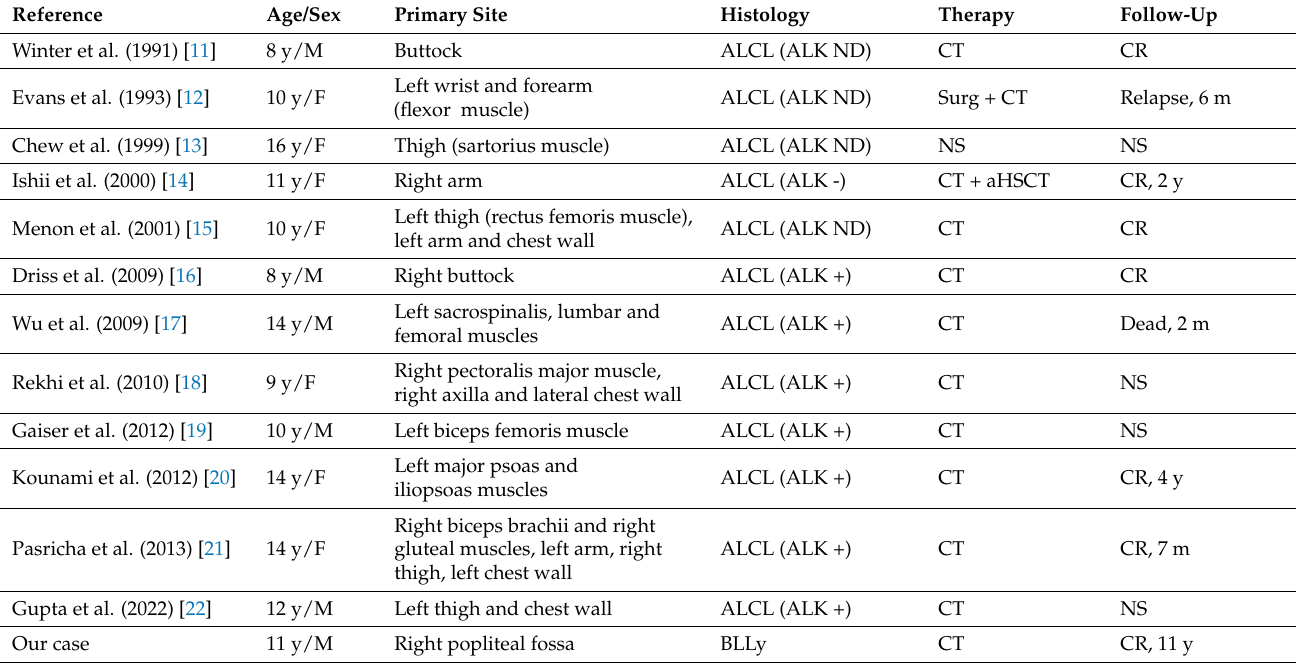
Table 2. Pediatric patients affected by PSTL reported in the